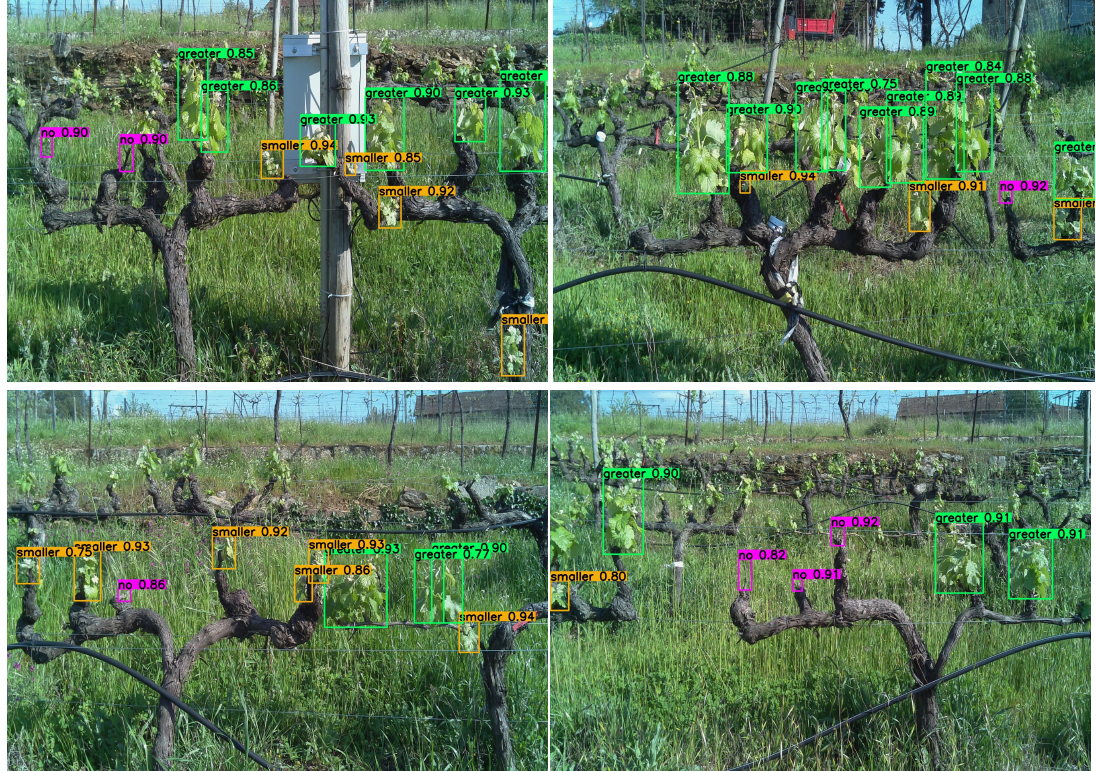
Figure 9. Grapevine’ shoots detection and classification results over acquired images.